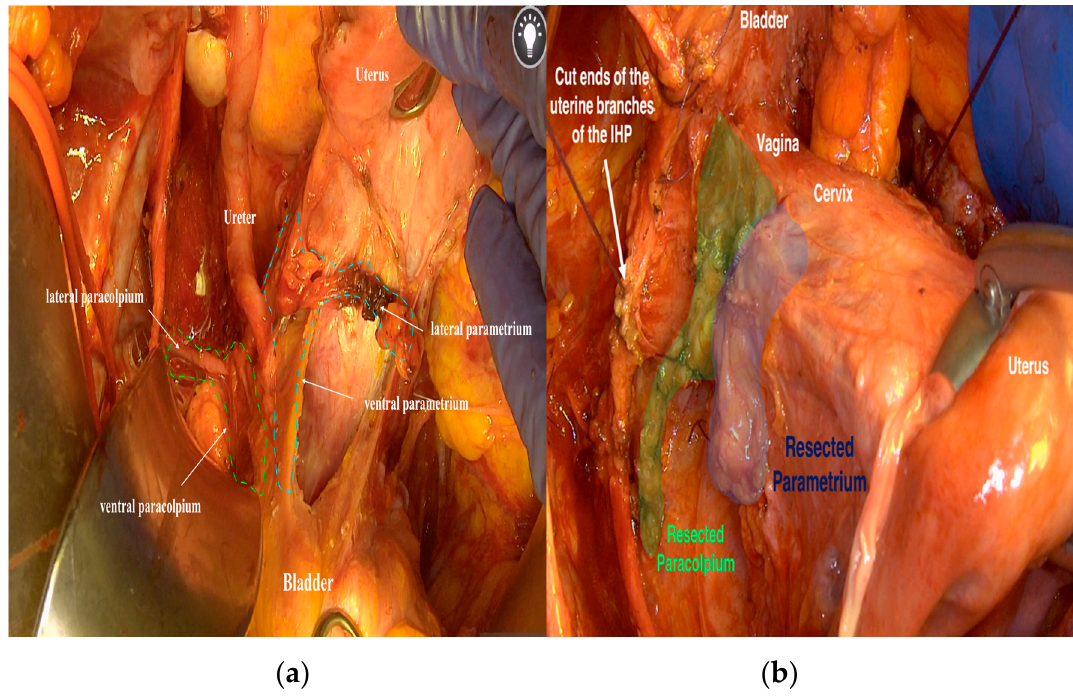
Figure 2. The lateral and ventral parametrium and paracolpium. ( a ) The ureter as an anatomical marker between the lateral parametrium and the lateral paracolpium and between the ventral parametrium and the ventral paracolpium. ( b ) The parametrium and paracolpium after resecting and sparing the pelvic autonomic nerve system. IHP: inferior hypogastric plexus.